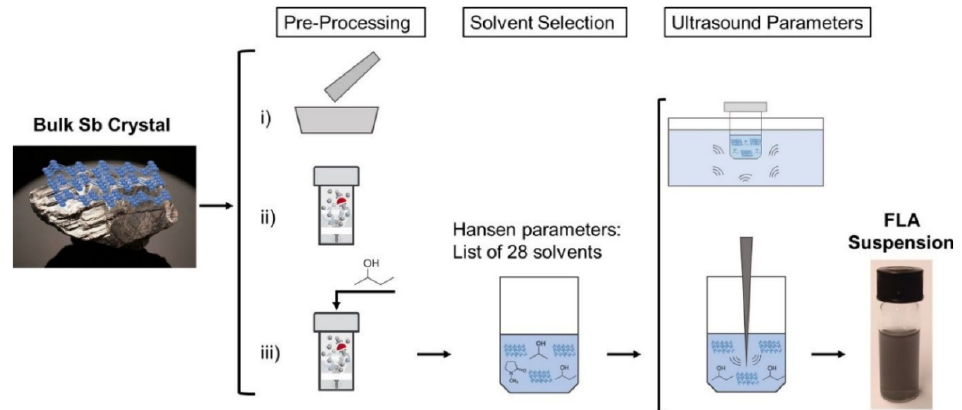
Figure 4. The liquid phase exfoliation process of antimony is summarized, including the different steps. Firstly, different methods are used for pretreatment: (i) grinding bulk antimony crystals; (ii) dry ball milling bulk antimony crystals; (iii) wet ball milled bulk antimony crystals. Secondly, the solvent was selected based on the parameters using 28 different solvents, and thirdly, the ultrasound parameters were compared, including bath ultrasound and tip ultrasound. Arrows highlight the best route to obtain layers of antimonene with the highest concentration. Reprinted with permission from Ref. [44]. Copyright 2019, Royal Society of Chemistry.